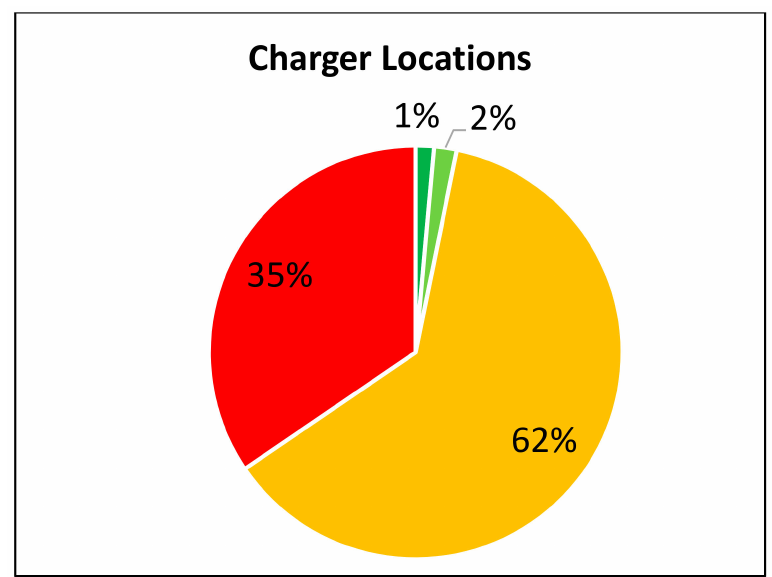
Figure 23. Respondent’s satisfaction of rapid charger locations.